Question: Author a descriptive caption for the visualization shown.
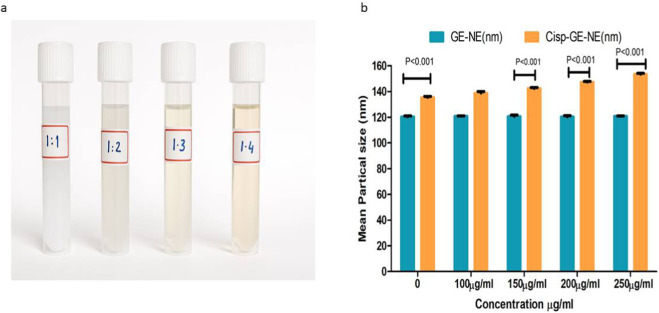
Answer: (a) Visual appearance of NE formulations prepared at varying oil-to-surfactant ratios (1:1, 1:2, 1:3, and 1:4). Increasing surfactant concentration resulted in improved clarity, indicating enhanced emulsification and reduced droplet size. The 1:4 ratio yielded the most transparent and stable nanoemulsion, suggesting an optimal formulation for drug delivery applications. (b) Mean particle size analysis of blank GE-NE and Cisp-GE-NE at increasing cisplatin concentrations (0–250 μg/mL). A concentration-dependent increase in particle size was observed upon drug loading, with all Cisp-GE-NE samples showing significantly larger sizes compared to GE-NE (P < 0.001). This indicates successful cisplatin incorporation without compromising nanoemulsion stability, maintaining sizes within the nanometric range favorable for drug delivery. Data are presented as mean particle size (nm) ± SD. A statistically significant increase in particle size is observed in Cisp-GE-NE compared to blank GE-NE across all concentrations (P < 0.001).